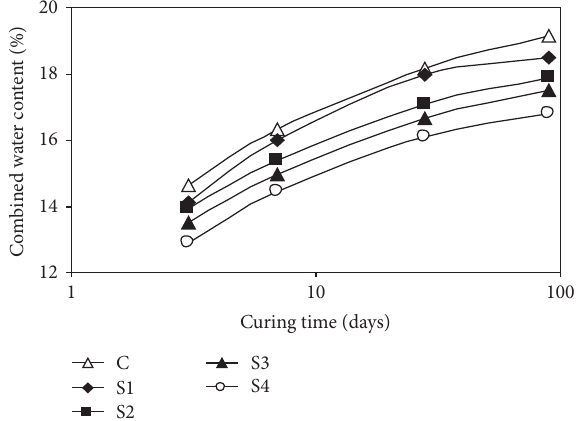
F 4: e combined water content of sewage sludge ash blended cement